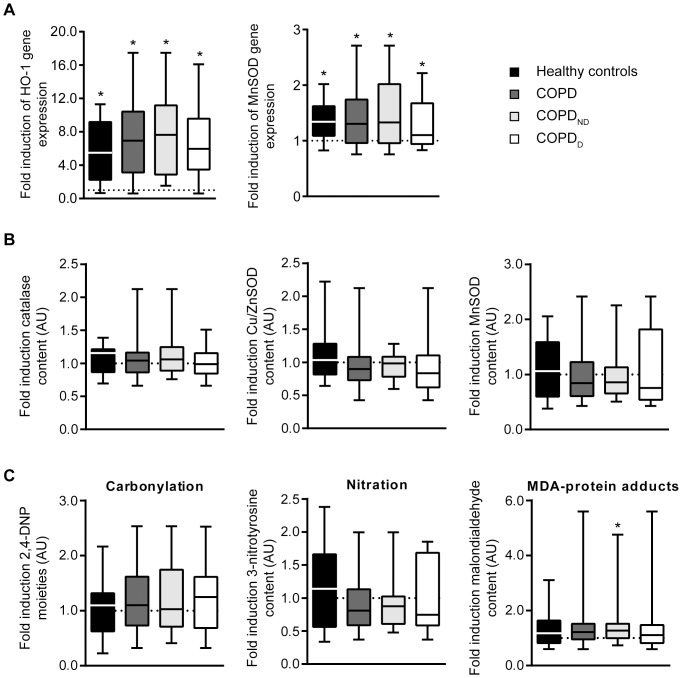
Oxidative stress in quadriceps muscle is only mildly increased in non-desaturating COPD patients; both patients and healthy controls show significant induction of antioxidant genes after exercise.
A Box plots of the response of heme oxygenase-1 (HO-1) and manganese superoxide dismutase (MnSOD) genes to exercise presented as fold induction (post/pre). B Box plot of the exercise-induced fold inductions of catalase, Cu/ZnSOD and MnSOD content. C Box plot of the exercise-induced fold inductions of protein carbonylation, tyrosine nitration and malondialdehyde (MDA)-protein adducts. Whiskers indicate minimum and maximum values. AU, arbitrary units. Level of significance: *p<0.05 for post vs. pre.